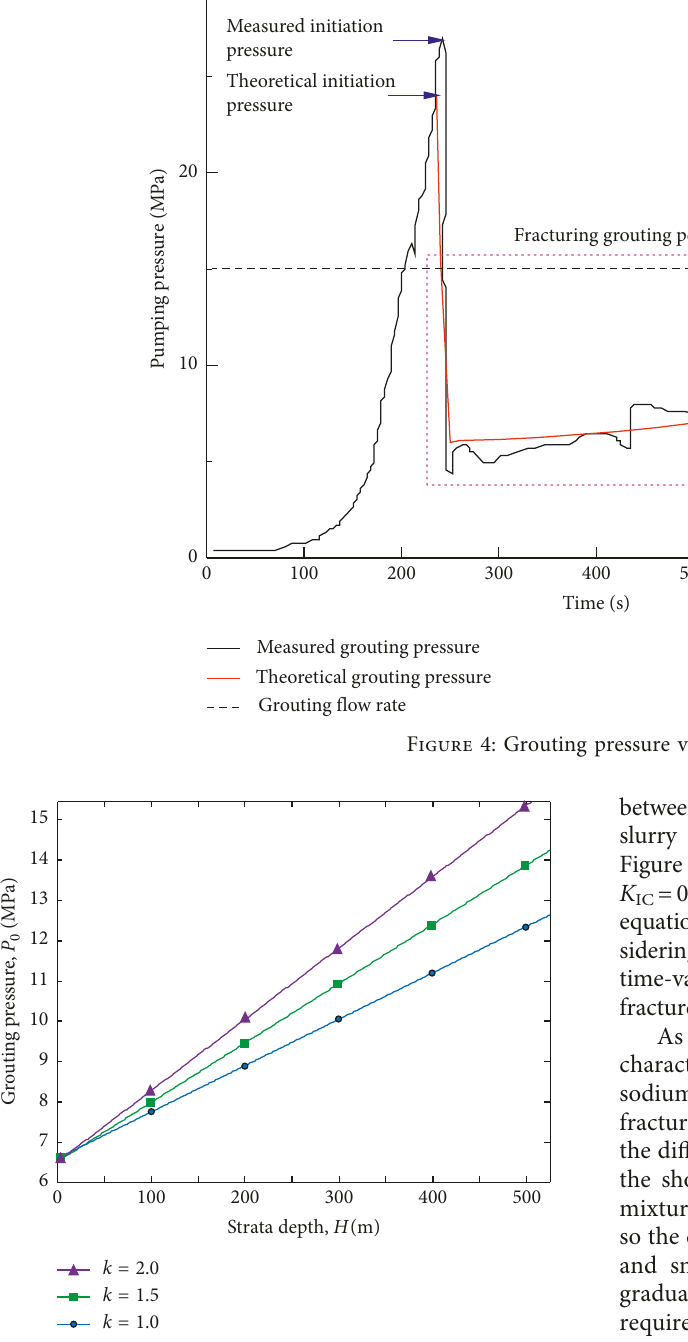
Figure 5: The influence of strata depth on the grouting